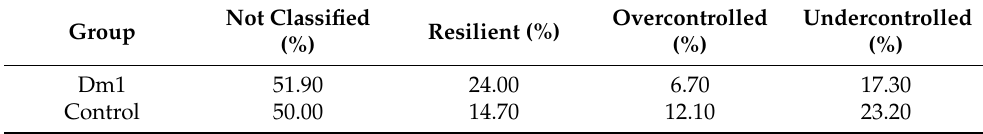
Table 1. Prototype percentages in Dm1 and Control samples.